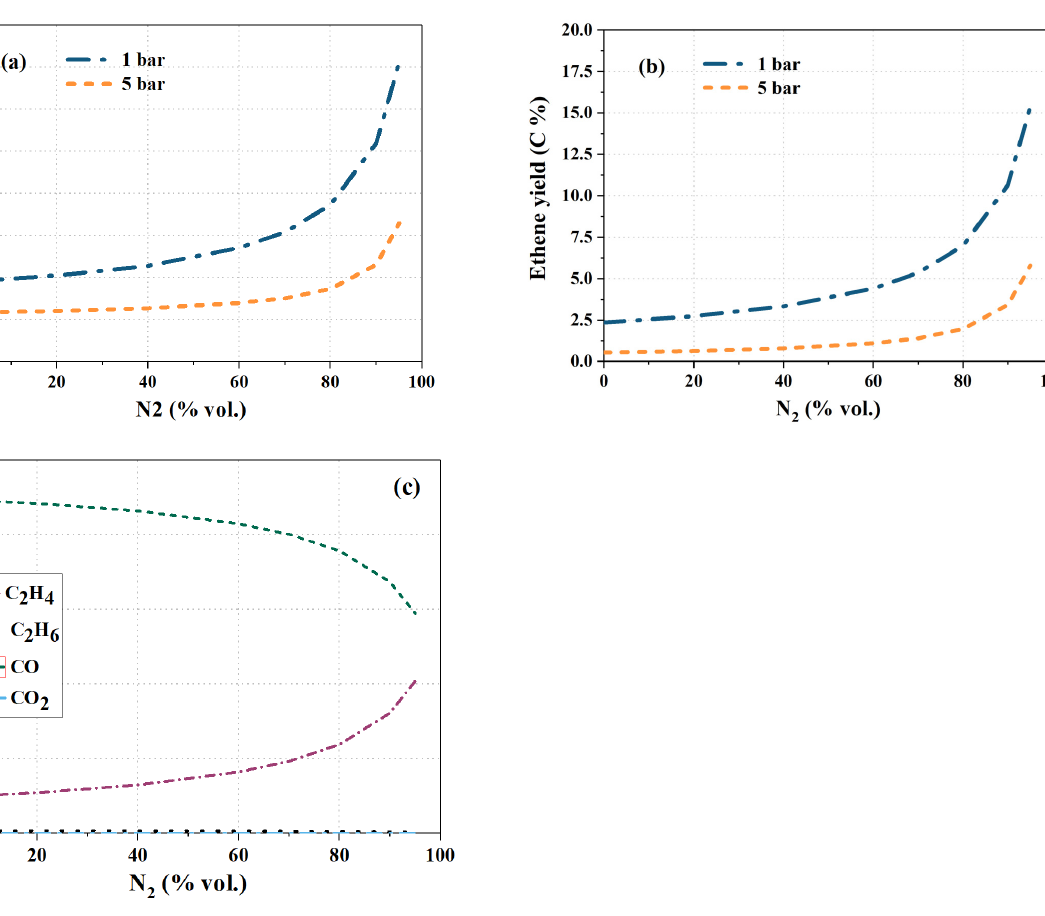
Figure 22. Effect of the inert composition and pressure at the CH 4 /O 2 feed ratio equal to 9 and 900 °C on the methane conversion ( a ); ethene yield ( b ); and carbon-based selectivity distribution at 1 bar ( c ). Feed composition comprised CH 4 , O 2 and N 2 only and inert composition was varied while keeping the total number of added mols and the CH 4 /O 2 feed ratio constant.